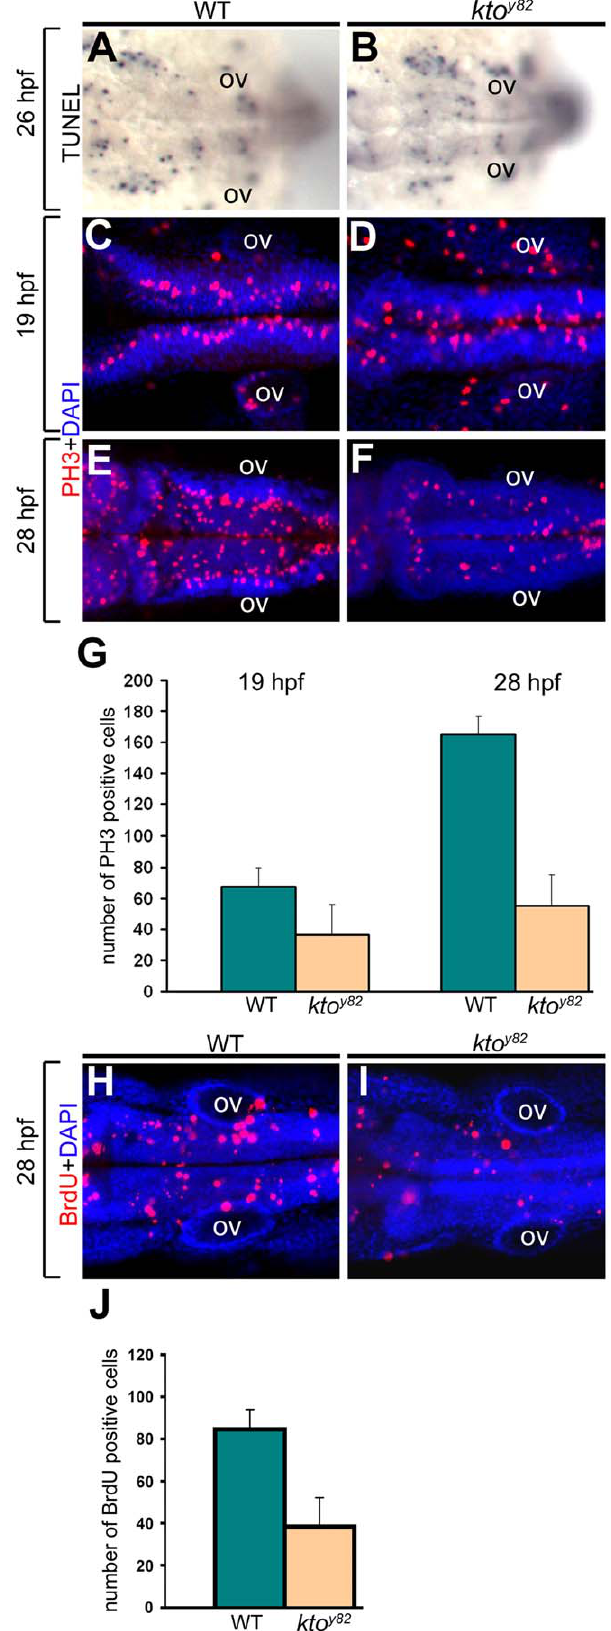
Figure 4. Cell proliferation defects in the hindbrain of kto y82 mutants. All images are dorsal views at 19 hpf (C,D), 26 hpf (A,B), and 28 hpf (E,F,H,I). (A,B) Analysis of cell death using TUNEL assay. (C–G) PH3 staining (C–F), and quantification (G) of PH3 positive cells in wt and kto embryos. (H–J) BrdU staining of wt and mutant embryos (H,I), and quantification of BrdU positive cells (J). Five embryos were counted for each condition; the error bars indicate 1 standard deviation based on 5 samples. PH3 staining at 19 hpf, wt vs. kto : p=0.003456; at 28 hpf, wt vs. kto : p=2.97e-05. BrdU staining, wt vs. kto : p=0.000706. ov, otic